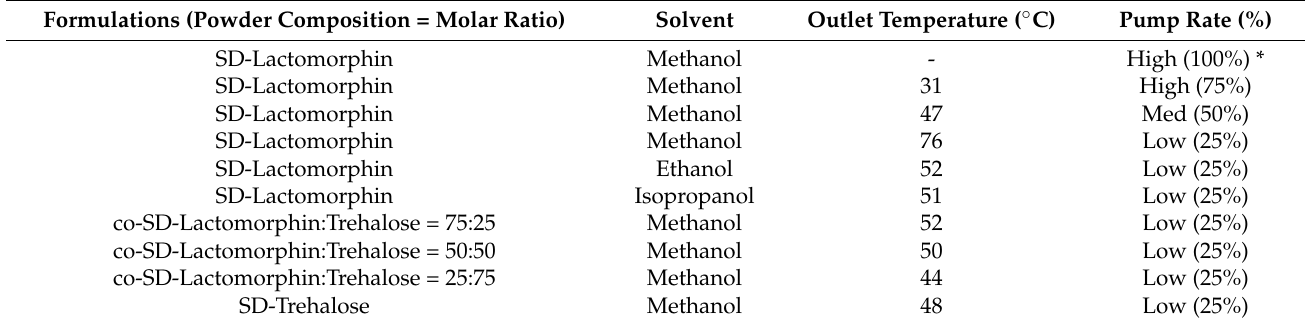
Table 1. Spray drying conditions for organic solution advanced spray drying in a closed mode under ultra-high purity nitrogen gas for Lactomorphin and Lactomorphin:Trehalose spray-dried and cospray-dried systems. Formulations (Powder Composition = Molar Ratio) Solvent Outlet Temperature ( ◦ C) Pump Rate